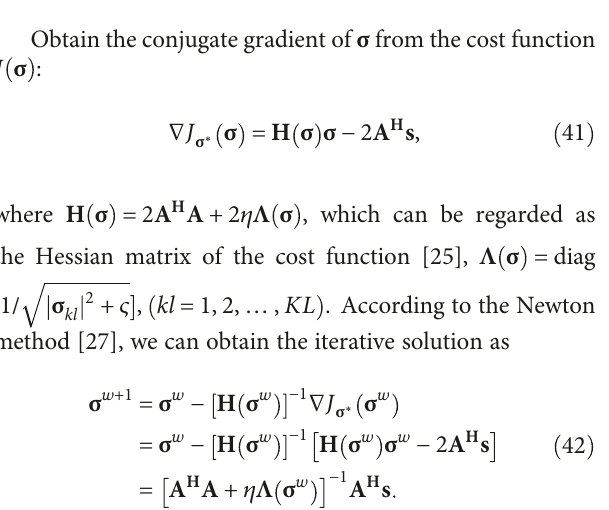
Figure 2: The scattering model of the high-speed